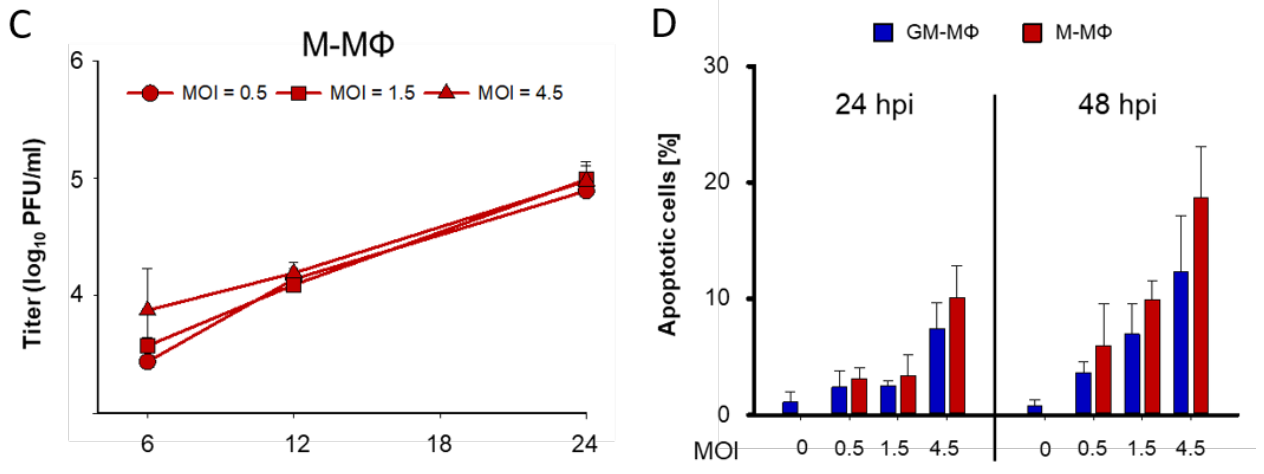
Figure 1. A higher initial infectious dose in GM- and M-M Φ s influences early release of extracellular virus particles and apoptosis induction. After infection of GM- and M-M Φ with three different MOIs the course of infection was analysed. ( A ) The number of RuV-positive cells was determined at 24 hpi through immunofluorescence analysis with anti-capsid antibodies. ( B , C ) The number of extracellular virus particles was determined by standard plaque assay. ( D ) Apoptotic cells were counted on a fluorescent microscope as cells with CellEvent Caspase 3/7 green reagent-positive nuclei in reference to the total cell number. ( A , D ) Two random fields per microscope slide were counted ( n = 3, biological replicates). Total cell number was determined through a DNA intercalat- ing dye.